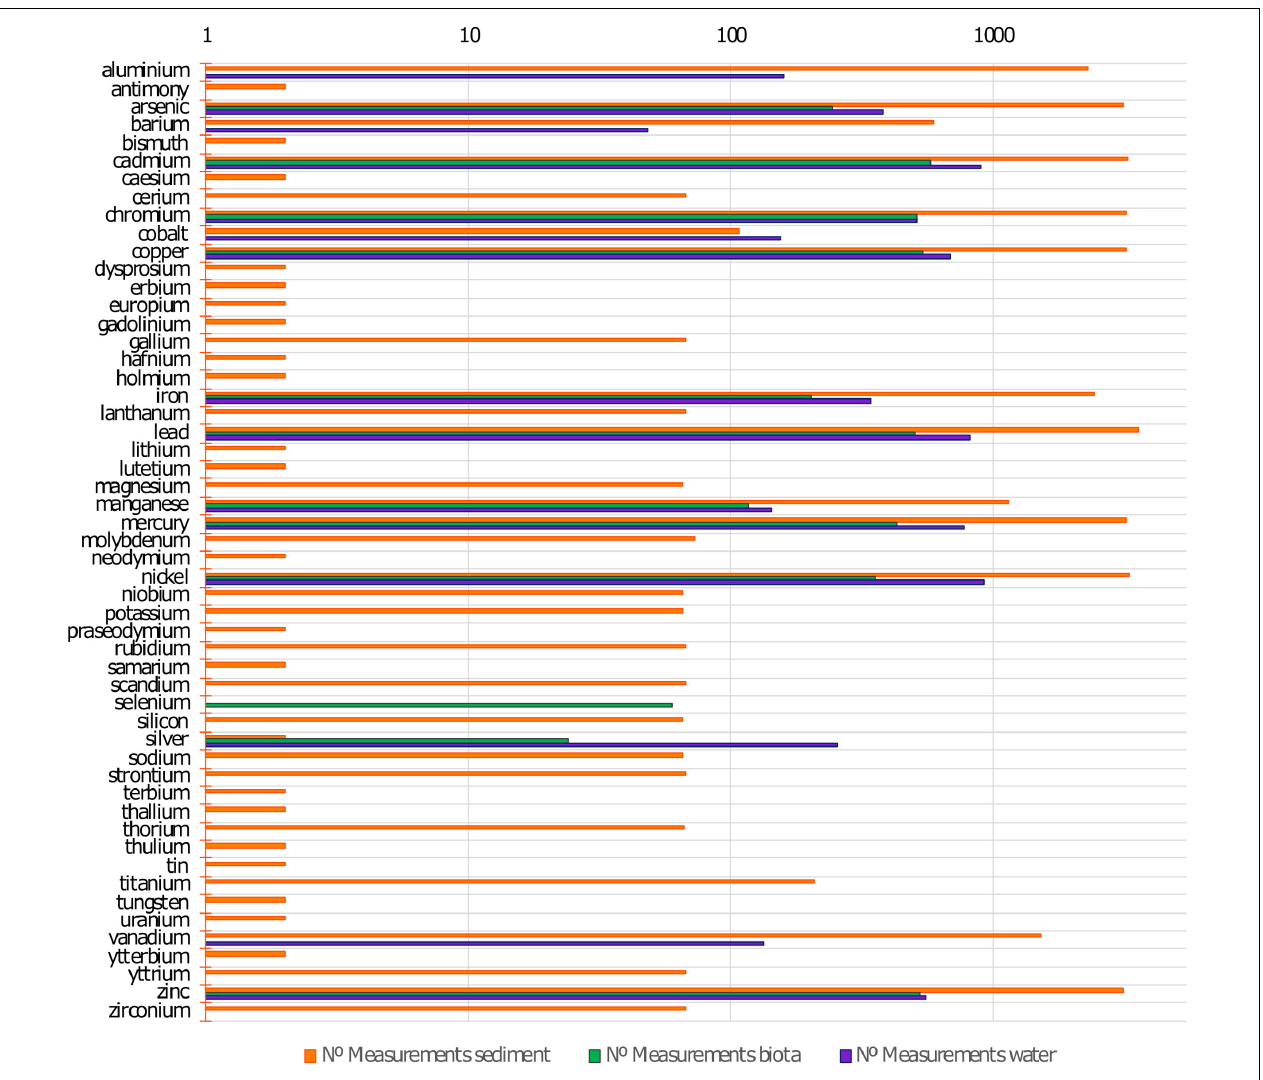
FIGURE 2 | Number of data available for heavy metals in sediment (orange), biota (green), and water (violet). Note the logarithmic scale.